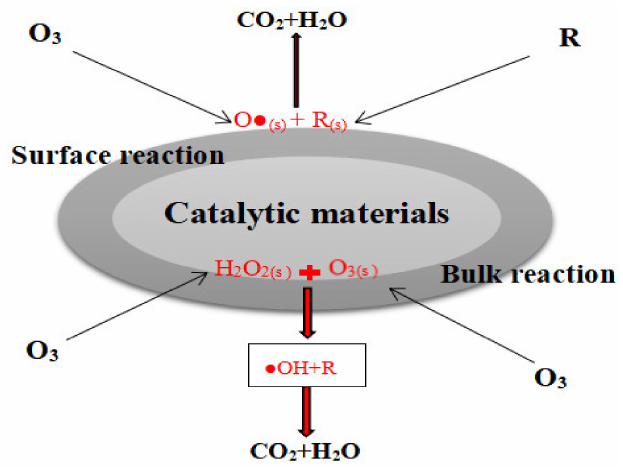
Figure 3. The main reaction pathway for the removal of pollutants by ozone oxidation (R, compound; R(s), adsorbed